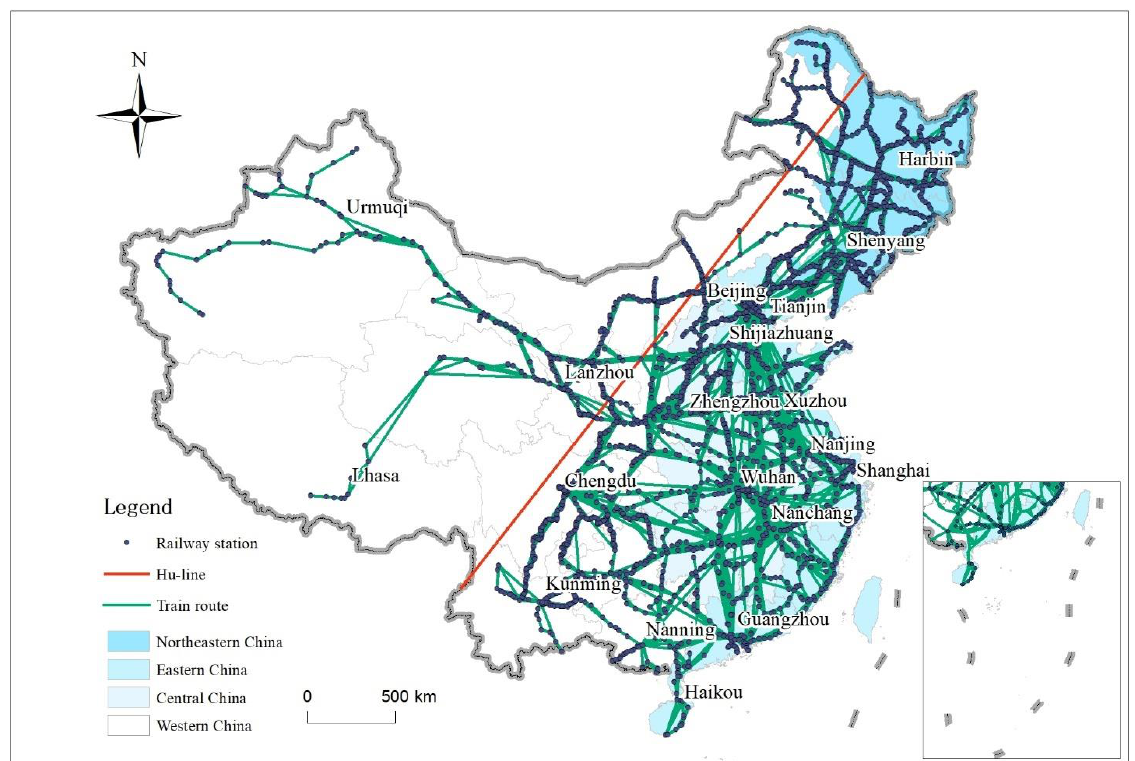
Figure 1. Spatial distribution of China’s railway stations and train routes. (The Hu line in Figure 1 extending from Aihui in Heilongjiang Province to Tengchong in Yunnan Province is a demographic demarcation. The southeast, with 36% of the country’s area, contains 96% of the Chinese population, while the northwest, with 64% of the total area, contains only 4% [42]. The ratios of populations of the two areas have not changed much despite changes in the national territory and massive urban migration in recent years). Table 1. Spatial distribution of railway stations in China.